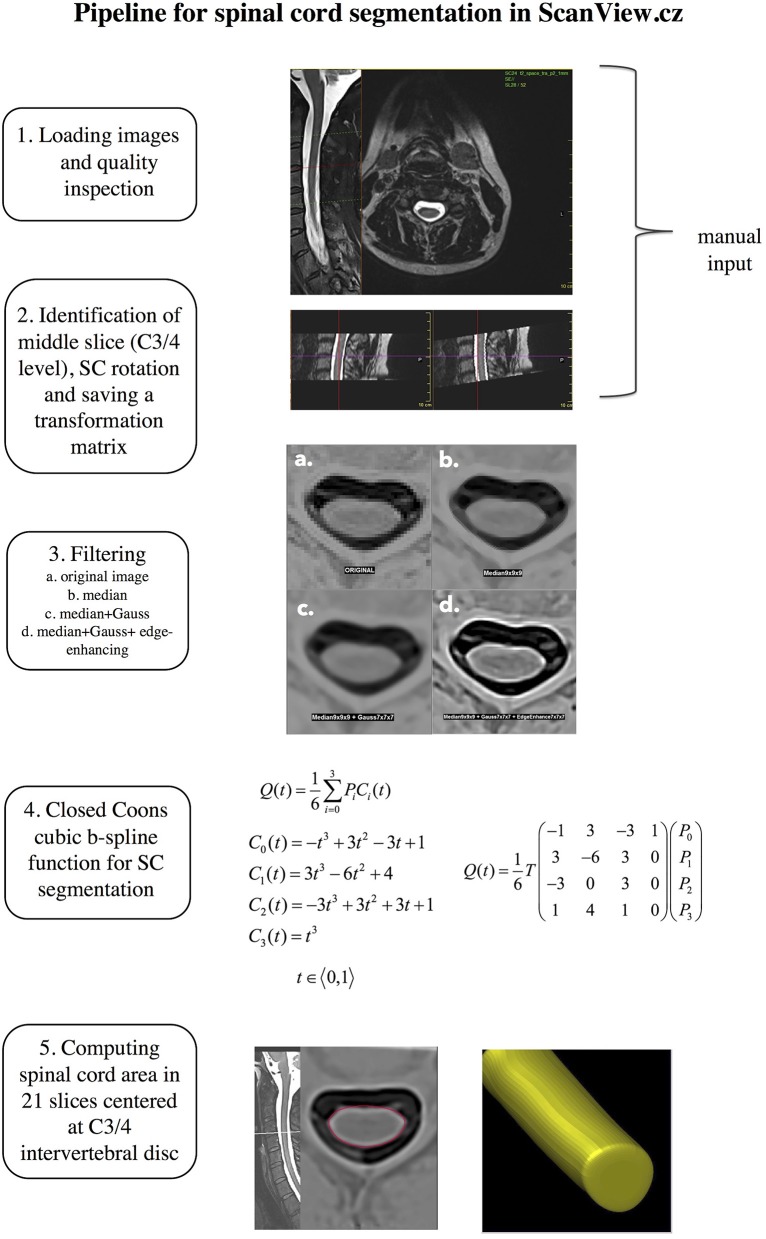
Schematic representation of the proposed pipeline for spinal cord segmentation.